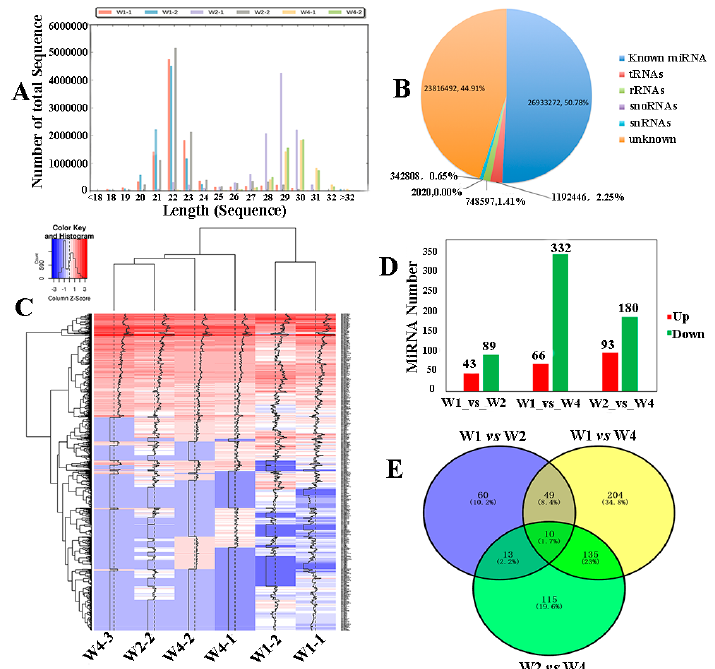
Figure 2. Identifying differentially expressed microRNA of small RNA sequencing. ( A ) The fragment length distribution of microRNAs in Tianzhu white yak testis. ( B ) The percentage statistics of small RNA in all samples. ( C ) The heatmap of all microRNAs in the three groups. ( D ) The statistical graph of the differentially expressed miRNAs (DERs) between groups. ( E ) The Venn diagram was constructed based on the aforementioned DERs by multiple comparisons of the three